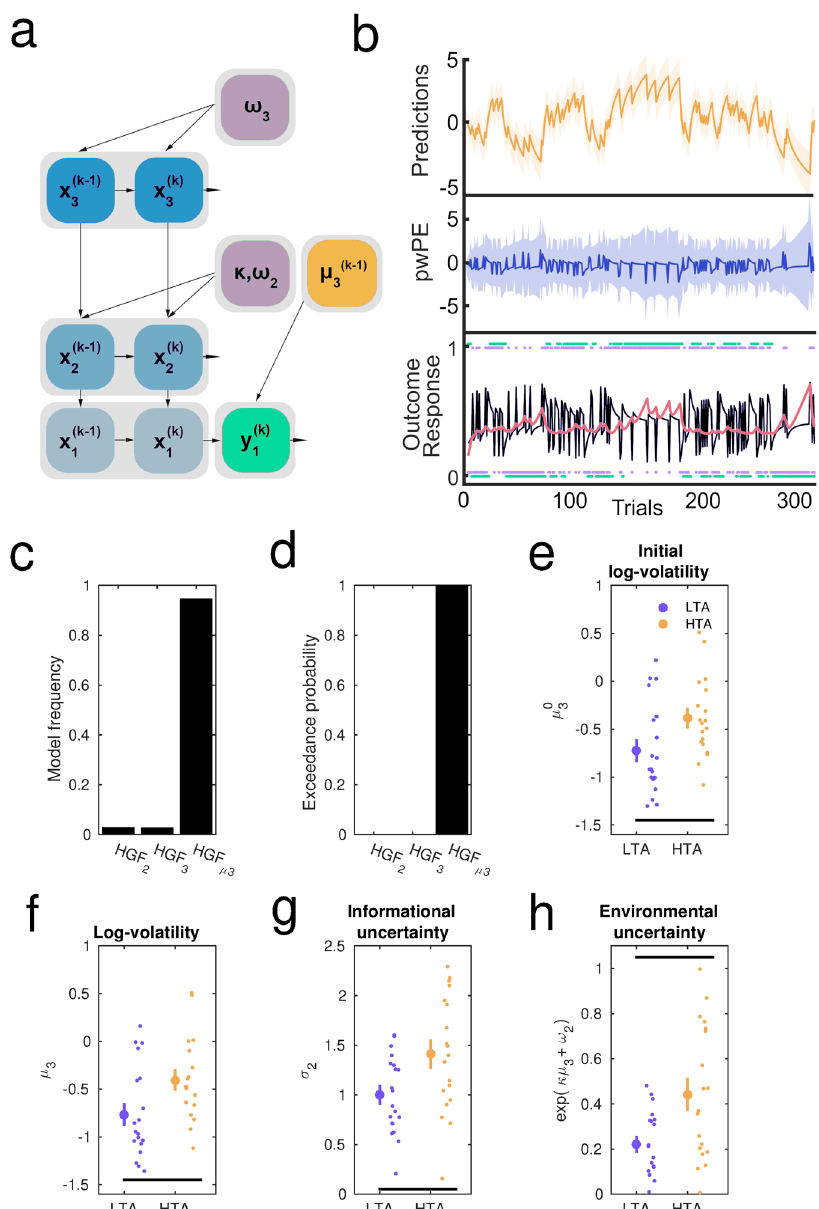
Fig. 2 Hierarchical Gaussian Filter: Winning model and results. a Representation of the three-level Hierarchical Gaussian Filter for binary outcomes with inverse decision noise being a function of the log-volatility prediction (estimate on the previous trial, k-1 ), μ 3 (k-1) . b Associated trajectories of relevant HGF outputs the total 320 trials in a representative participant. At the lowest level, the inputs correspond to the rewarded outcome of each trial (1 = blue, 0 = orange; shown as purple dots). The participant ’ s responses y are shown in green dots tracking those trial outcomes. The black line indicates the series of prediction errors (PE) about the stimulus outcome, and the salmon pink line the precision weight on level 2. The middle layer of (b) shows the trial-wise HGF estimate of pwPE about stimulus outcomes (pwPE updating level 2, simply termed pwPE in the graphic; deep blue). For our main GLM convolution analysis, we used unsigned values of pwPE updating level 2 as one of the parametric regressors. The precision ratio included in the pwPE term weights the in fl uence of prediction errors about stimulus outcomes on the expectation of beliefs on level 2. Predictions about the tendency towards a stimulus-reward Þ are displayed on the top level (yellow). We took the absolute values of this quantity as our main parametric regressor (labelled contingency on level 2 ð ^ μ 2 simply Predictions in the graphic) in a separate exploratory GLM analysis. c , d Bayesian model selection (BMS). The panels show the model frequency (c) and exceedance probability (d) for each of the HGF models we tested: the 2-level HGF (HGF 2 ), the 3-level HGF (HGF 3 ), and the 3-level HGF informed by trial-wise estimates of volatility (HGF μ 3 ) given in black. The HGF μ 3 model best explained the data (exceedance probability = 1; expected frequency = 0.95). e HTA individuals (yellow; N = 19 participants) had a greater initial expectation or prior on log-volatility than LTA (purple, N = 20 participants ; P FDR = 0.024 < 0.05; group effects denoted by the black line at the bottom). Data in each group are represented by the mean (large dot) with SEM bars. Individual data points are illustrated to the right. f Over time, the posterior mean on log-volatility ( μ 3 ) in HTA remained signi fi cantly higher relative to LTA ( P FDR = 0.019 < 0.05). g Informational (estimation) belief uncertainty about the stimulus outcome tendency was greater in HTA compared with LTA ( P FDR = 0.0138 < 0.05). h The HTA individuals were also signi fi cantly more uncertain about the environment ( P FDR = 0.0052 < 0.05). No signi fi cant differences were found in uncertainty about volatility ( σ 3 ) or the tonic learning rates at levels 2 ( ω 2 ) and 3 ( ω 3 ).